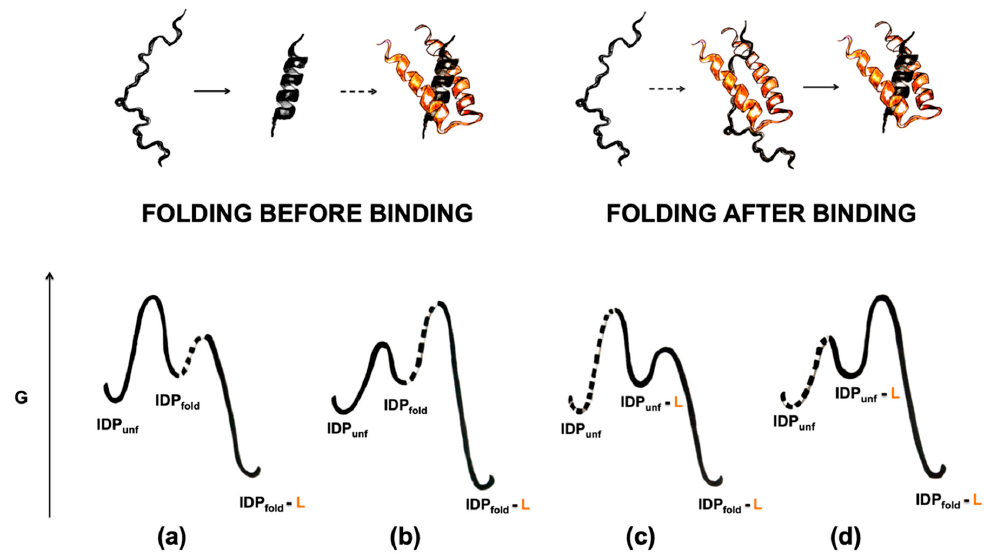
Figure 2. Conformational selection (Folding before binding) and Induced-fit (Folding after binding) models and related free energy diagrams. The ligand (L) and the intrinsically disordered protein (folded, IDP fold, and unfolded IDP unf ) are colored in black and orange respectively. A plausible energy diagram arising in different kinetic conditions is depicted in panels ( a )–( d ), in all cases the bimolecular binding reaction is highlighted with dashed lines. The implications of different scenarios are discussed in the text.